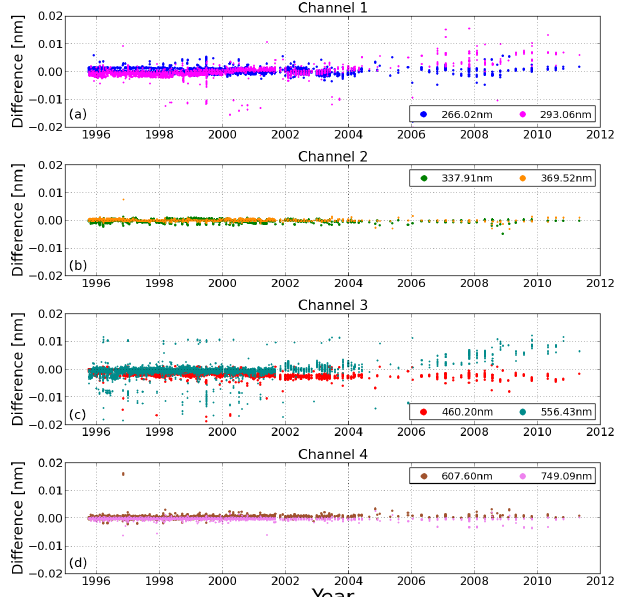
Figure 9. Change in wavelength (with respect to the beginning of the mission) as a function of time from 1995 to 2011 for two se- lected lamp lines per channel. From (a) to (d) : channel 1, channel 2, channel 3, and channel 4.